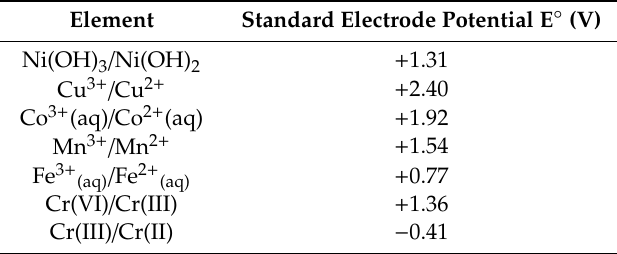
Table 1. Standard electrode potential (E ◦ ) of elements with an unstable + 3-oxidation state. Value for Ni ref. [48]; all others values from